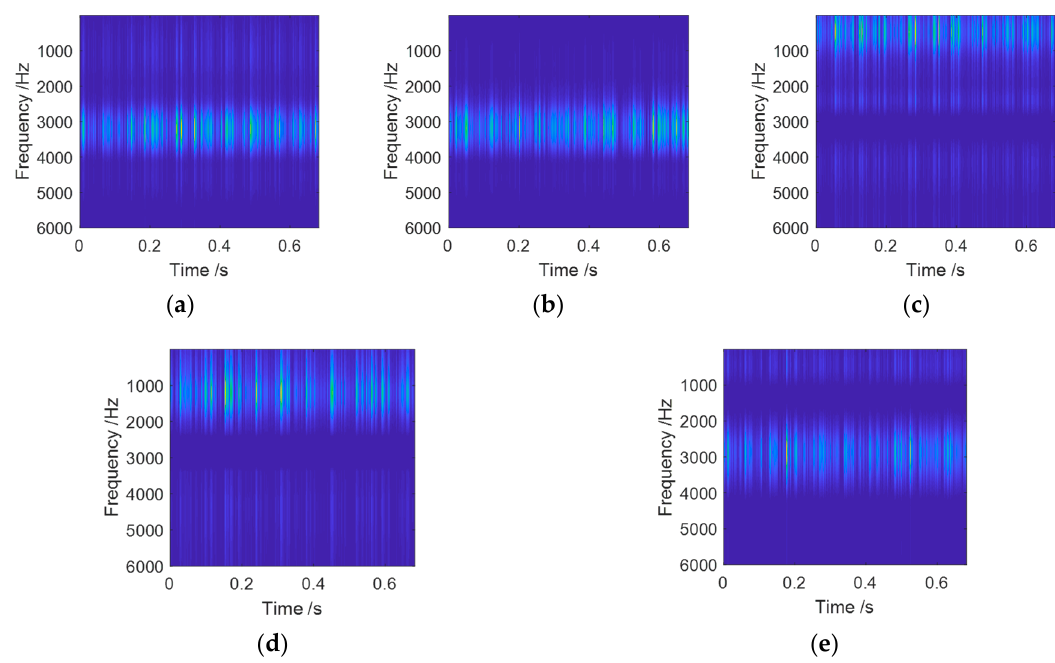
Figure 15. Illustrations of the reconstructed TFDs: ( a – e ) Reconstructed TFD 1–5. Components lie in different frequency band after tensor factorization and reconstruction.